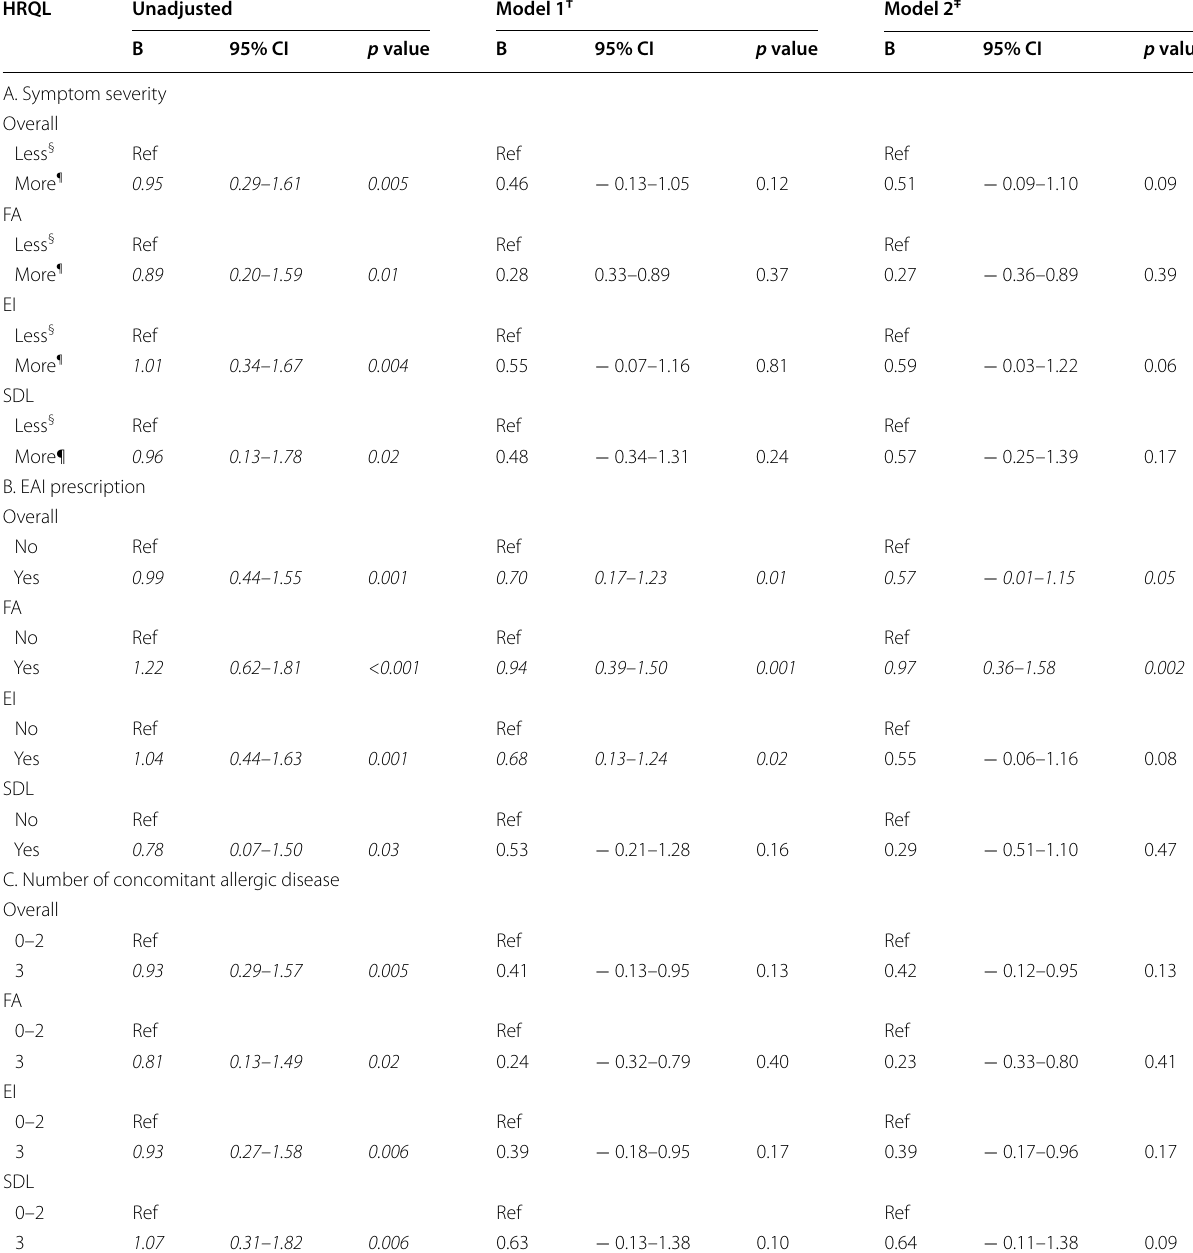
Table 2 Linear regression analyses for children with specialist-diagnosed food allergy, by proxies of severity (n